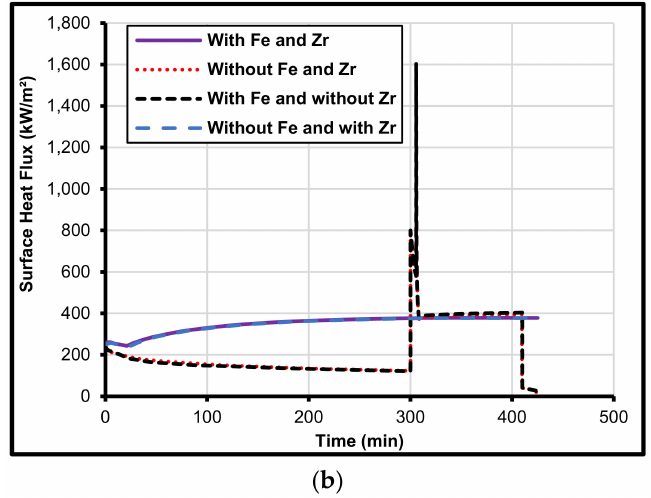
Figure 12. Effect of Fe, Zr, and their various combinations during MCCI at 425 min on ( a ) ablation depth and ( b ) surface heat flux.